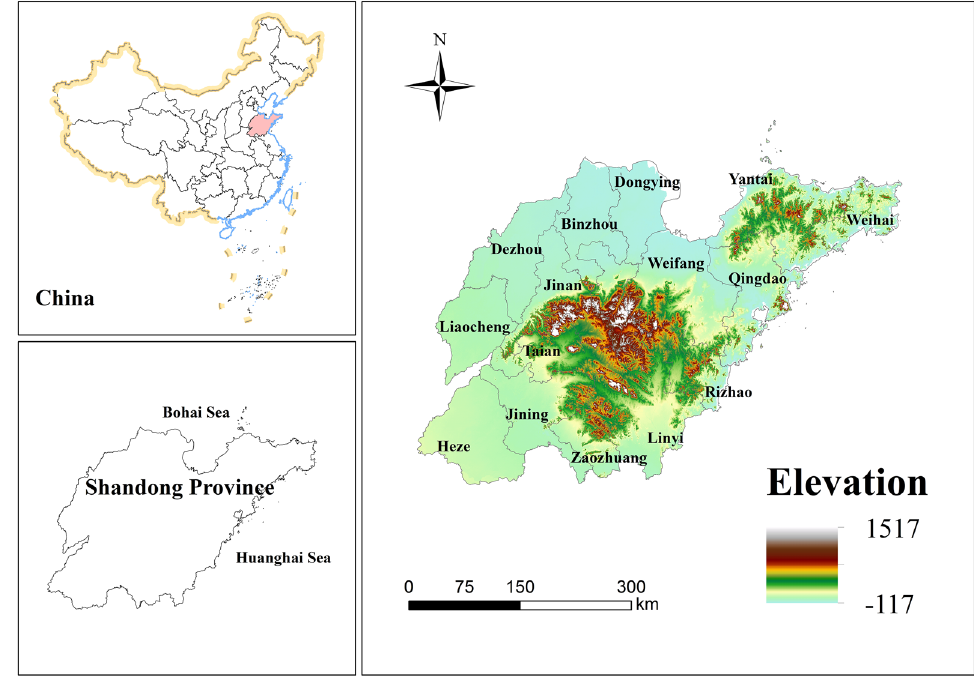
Figure 1. Study area.